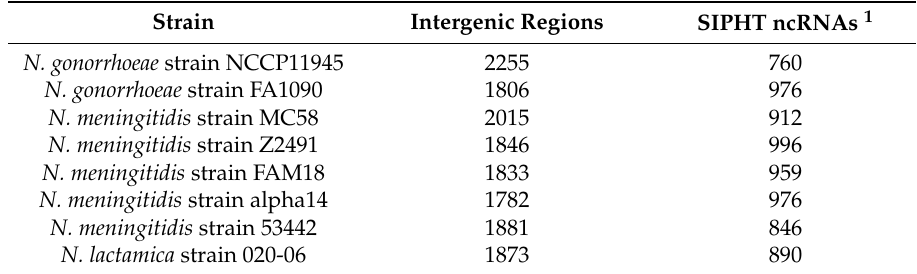
Table 1. Number of intergenic regions and predicted non-coding RNAs (ncRNAs) in Neisseria spp. genome sequences.